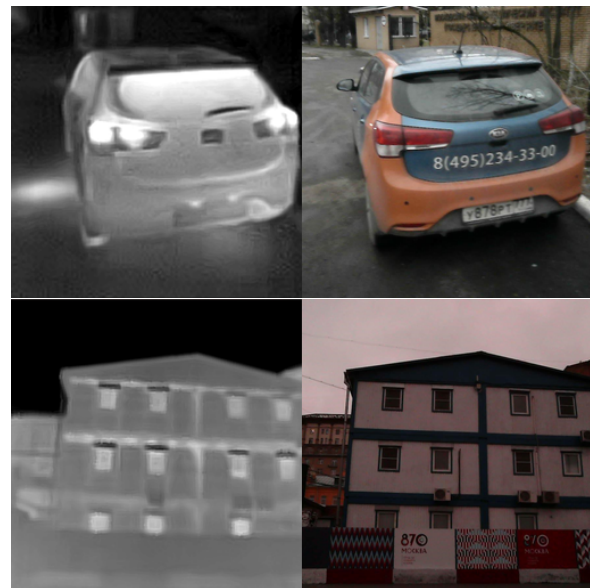
Figure 3. Examples from the training dataset